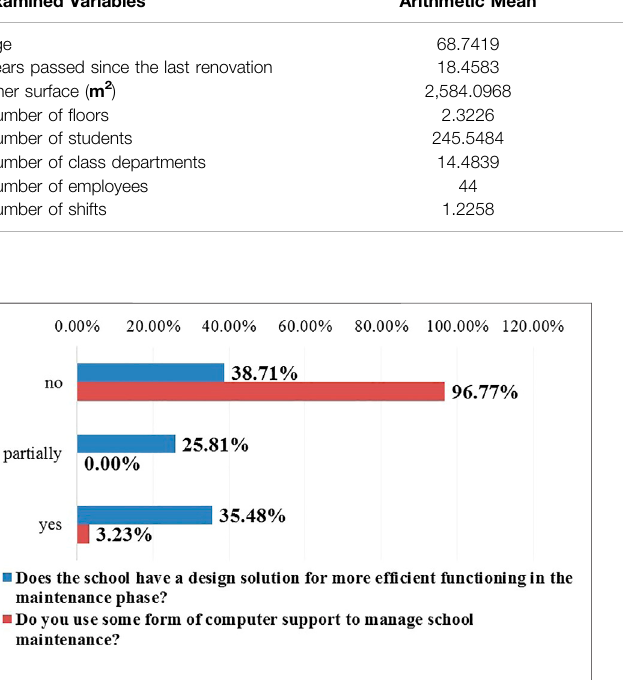
FIGURE 4 | Shares of response (assessment) of the condition of school